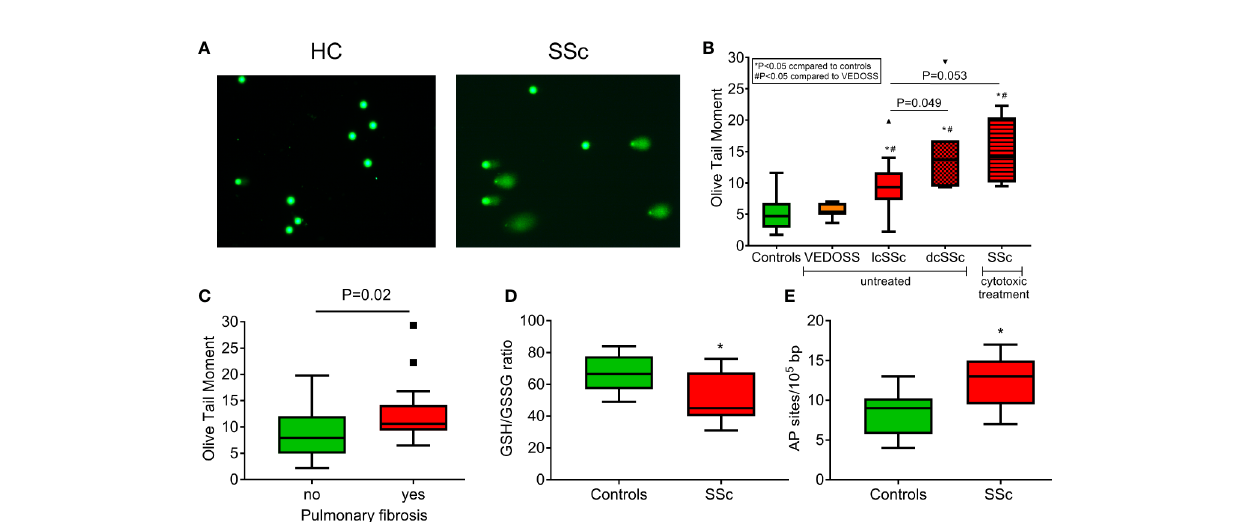
FIGURE 1 | Increased endogenous DNA damage formation and accumulation in SSc. (A) Representative alkaline comet assay images of untreated peripheral blood mononuclear cells (PBMCs) from a control (HC) and an SSc patient. (B) Tukey boxplots representing the endogenous DNA damage levels (Olive tail moment arbitrary units) as assessed by alkaline comet assay in PBMCs from controls ( n =55), VEDOSS ( n =7), patients with limited ( n =18) or diffuse ( n =7) SSc currently on no cytotoxic therapy and patients with SSc under cytotoxic treatment ( n =5). P -values are derived from Mann-Whitney U test; * P<0.05 compared to controls, # P<0.05 compared to VEDOSS. (C) Tukey boxplots representing the endogenous DNA damage levels (Olive tail moment arbitrary units) as assessed by alkaline comet assay in PBMCs of SSc patients with ( n =17) or without ( n =20) pulmonary fi brosis. P -value is derived from Mann-Whitney U test. Tukey boxplots representing oxidative stress levels, expressed as the GSH/GSSG ratio (D) and the number of AP sites per 100,000 base pairs (E) in PBMCs of HC ( n =10) and SSc patients ( n =9). None of the patients were currently on cytotoxic therapy. *P<0.05 compared to